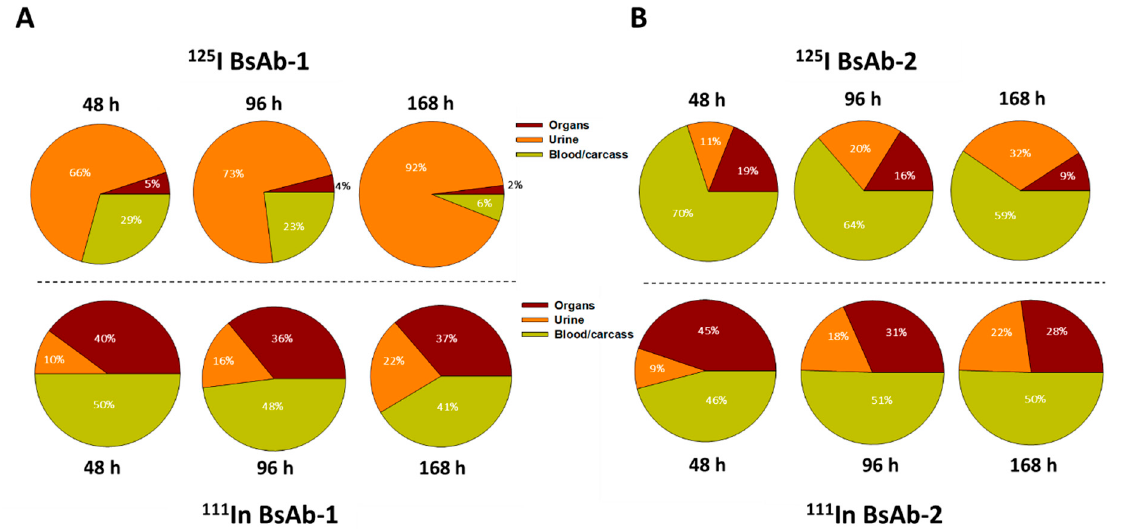
Figure 3. Percent of radioactive recovery data for ( A ) BsAb ‐ 1 and ( B ) BsAb ‐ 2 in male cynomolgus monkeys following a single IV administration of ~5 mg/kg (~0.015 mCi 125 I ‐ and 111 In ‐ labeled BsAb ‐